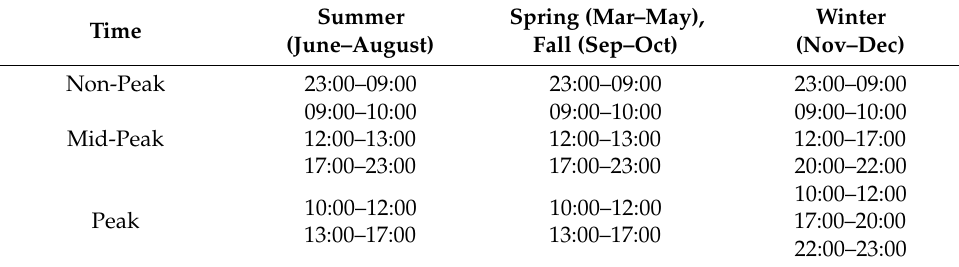
Table 3. Electric rate table for TOU price in Korea.